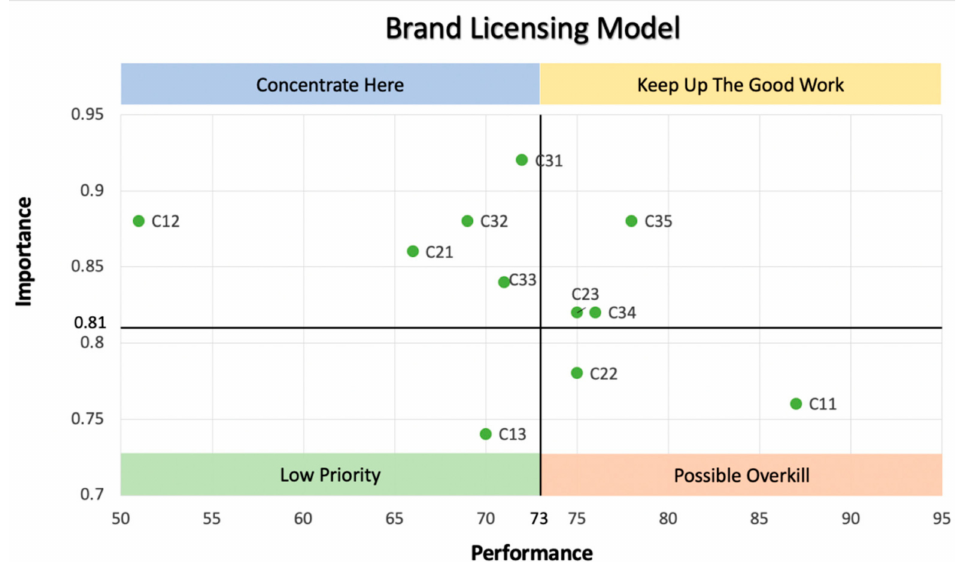
Figure 4. Importance–Performance Grid of Brand licensing